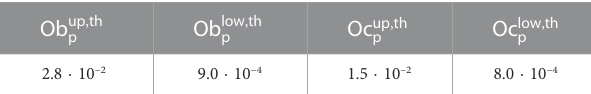
TABLE 1 Nominal values of the thresholds.